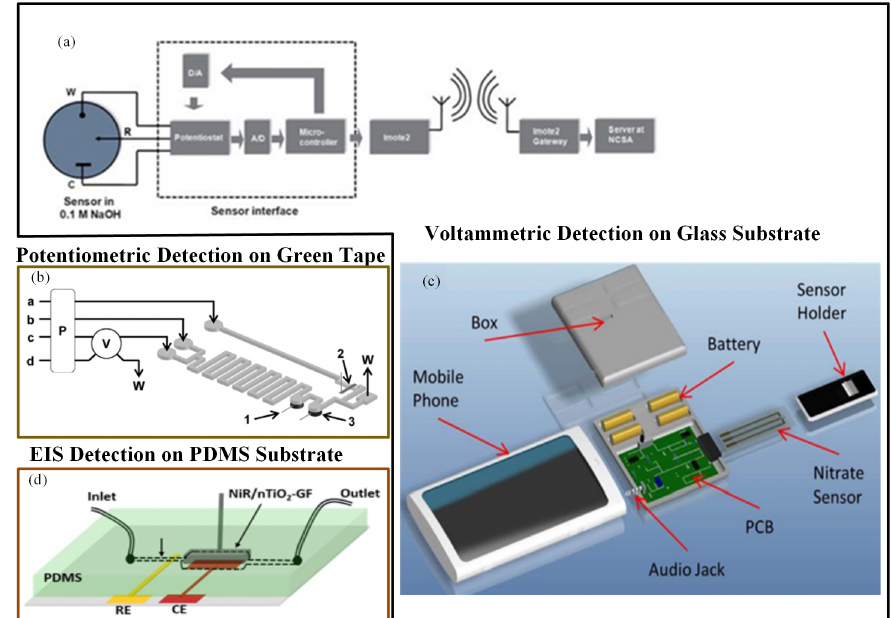
Figure 5. ( a ) Nitrate sensor chip with wireless communication interface [113]; ( b ) experimental set up of low-temperature co-fired ceramics (LTCC)-based continuous flow potentiometric microanalyzer to determine potassium and nitrate [115]; ( c ) a mobile sensing platform with a plug-n-play microelectronic ionic sensor to detect nitrate [114]; and ( d ) nTiO2-modified graphene foam (GF)-based nitrate sensor